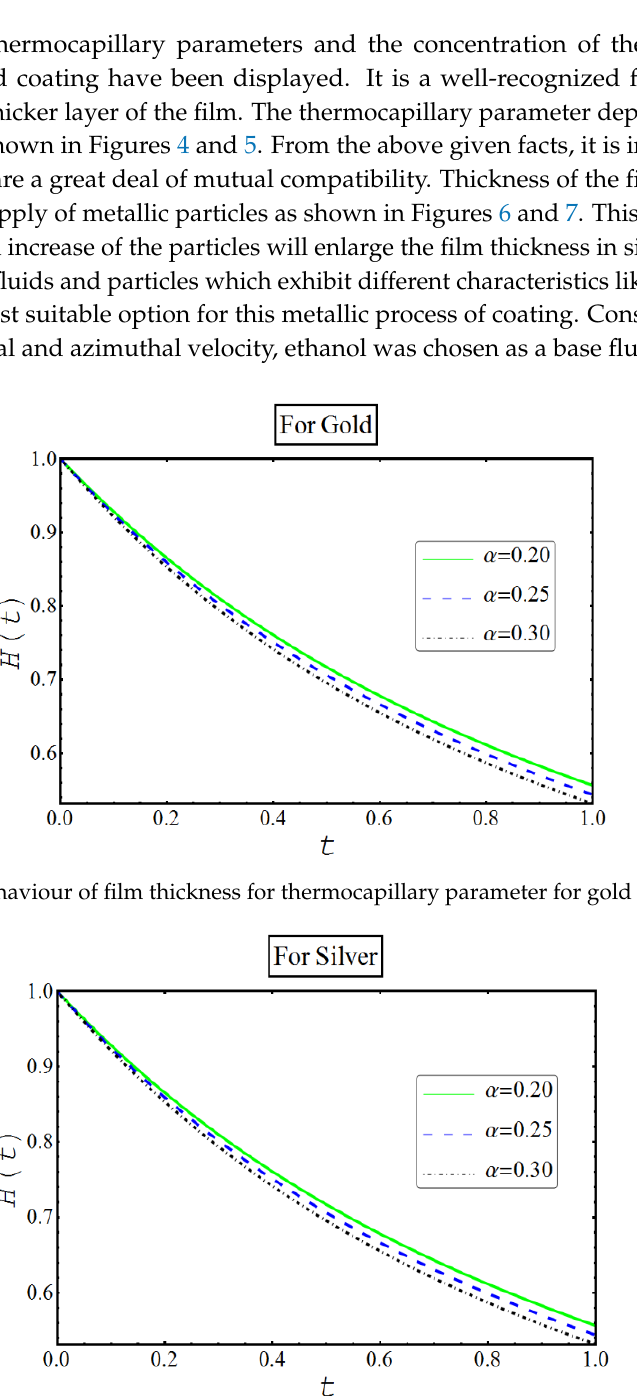
Figure 5. Behaviour of film thickness for thermocapillary for silver particles parameter.